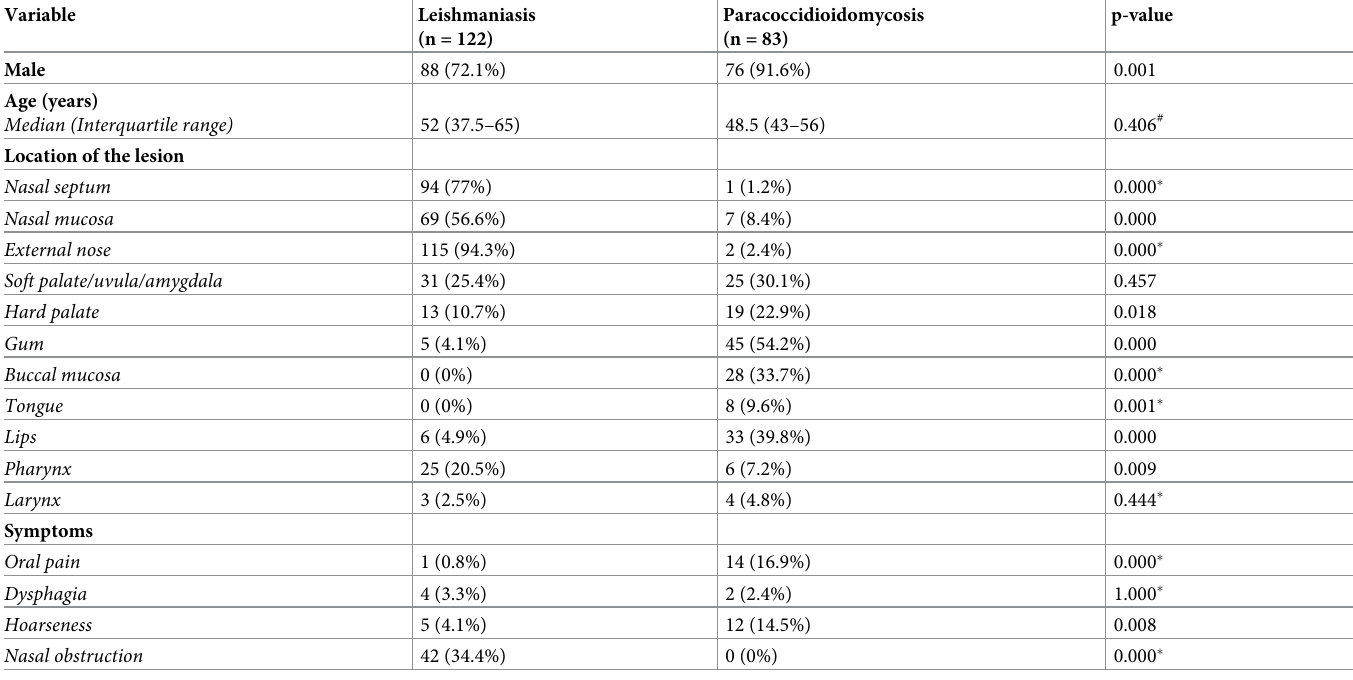
Table 1. Comparison of demographic and clinical characteristics in leishmaniasis and paracoccidioidomycosis. Variable